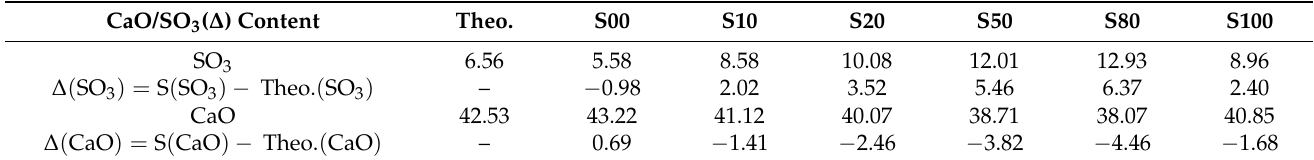
Table 3. CaO and SO 3 content of clinkers and their differences between quantitative and theoreti- cal